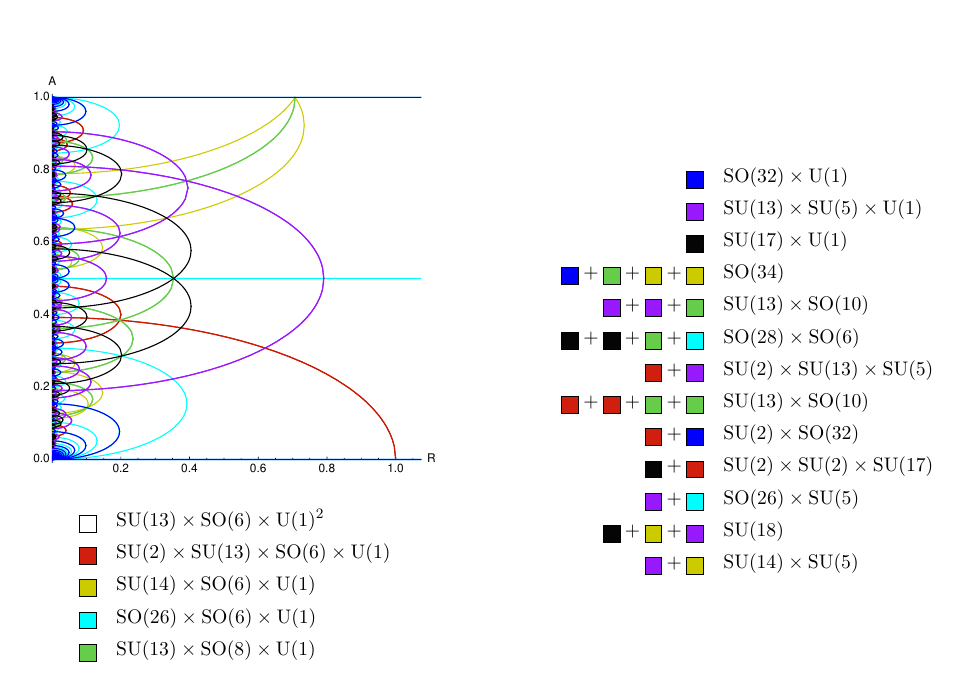
Figure 20. SO(32) heterotic with Wilson line A I = (( A ) 13 ; 0 3 ).